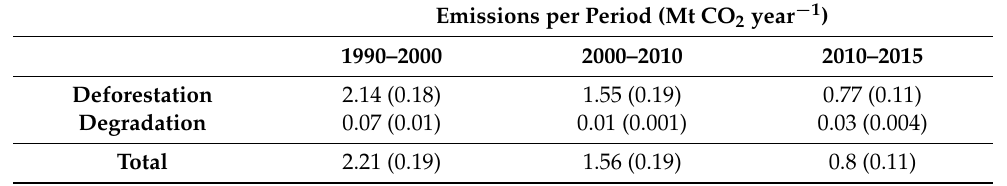
Table 4. Estimated emissions from deforestation and forest degradation in the Caparo Forest Reserve between 1990 and 2015. Values in parenthesis are standard error of the